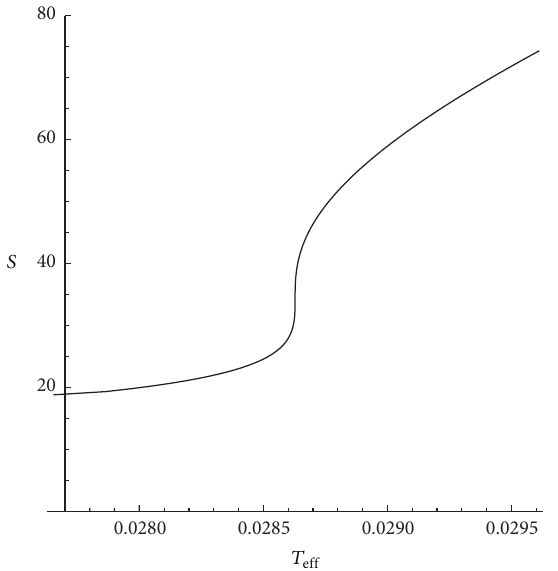
Figure 3: 𝑆 - 𝑇 curves for charged GB-dS black hole with 𝑄 = 1 , eff 𝑑 = 5 , and ̃𝛼 = 0.1 .